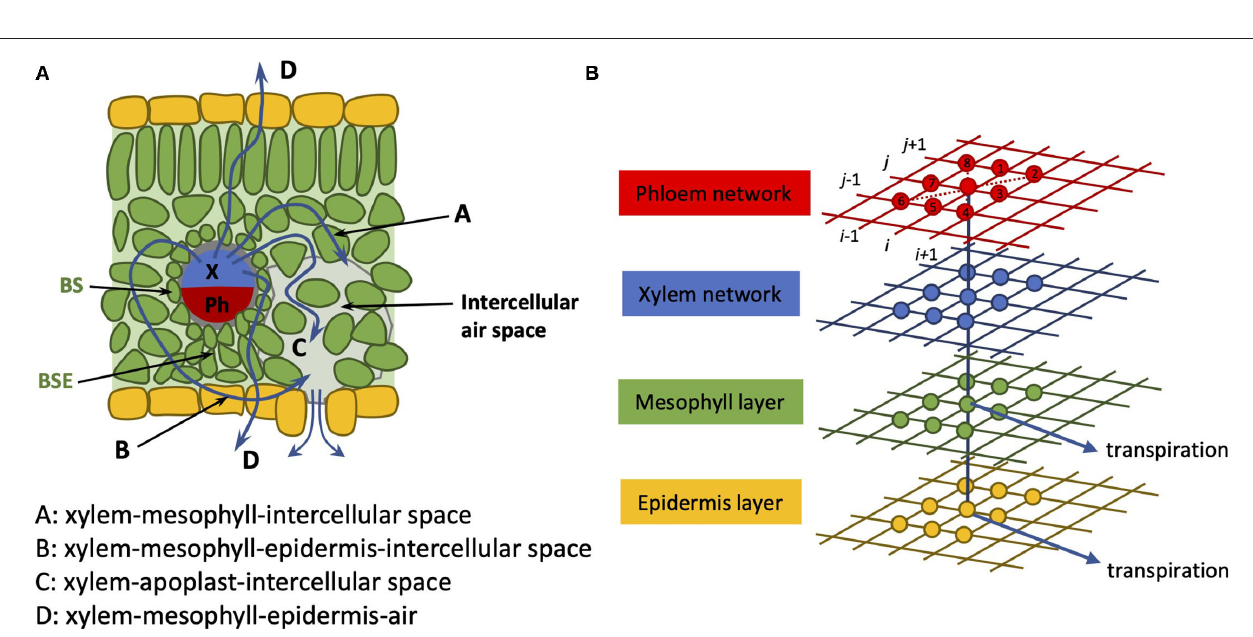
FIGURE 1 | Vein architecture of the model leaf. The angle of the second-order vein to the main vein is kept fixed at 45 ◦ , the higher order veins are laid out as a rectangular grid (middle sub-panel). The right-most sub-panel shows a schematic of the tissue structure presumed at each node.